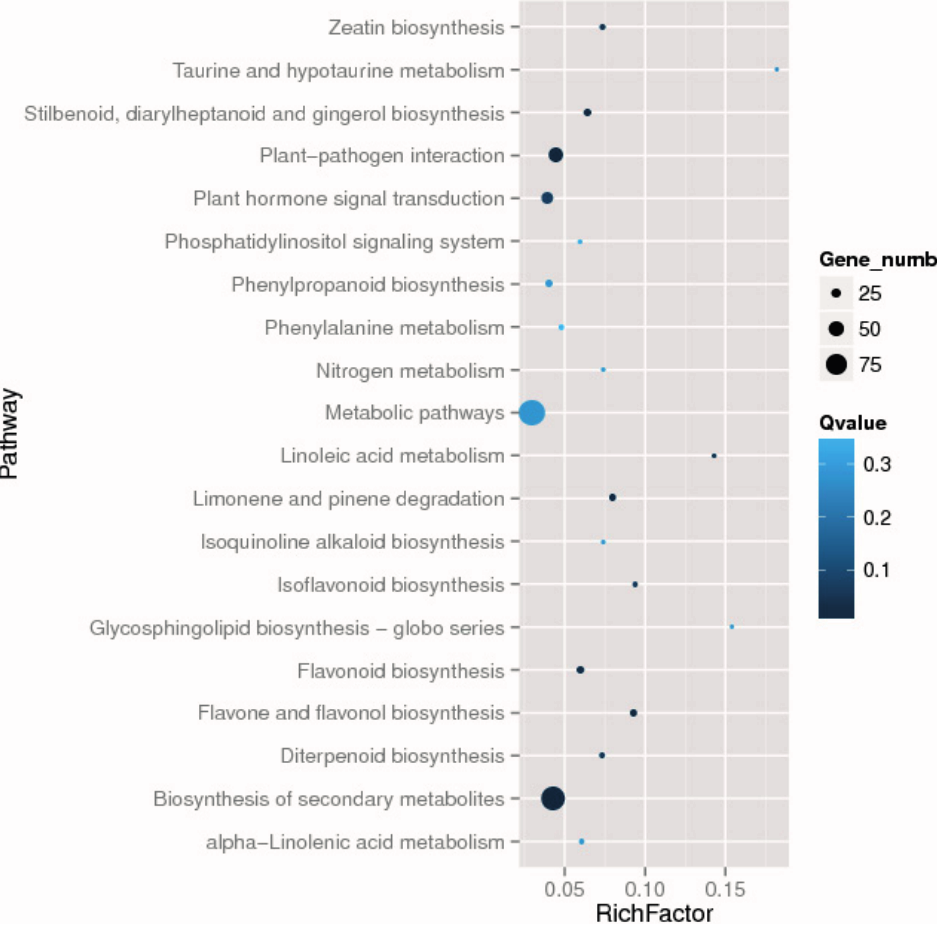
Figure 6. The top 20 enriched KEGG pathways among the differentially expressed